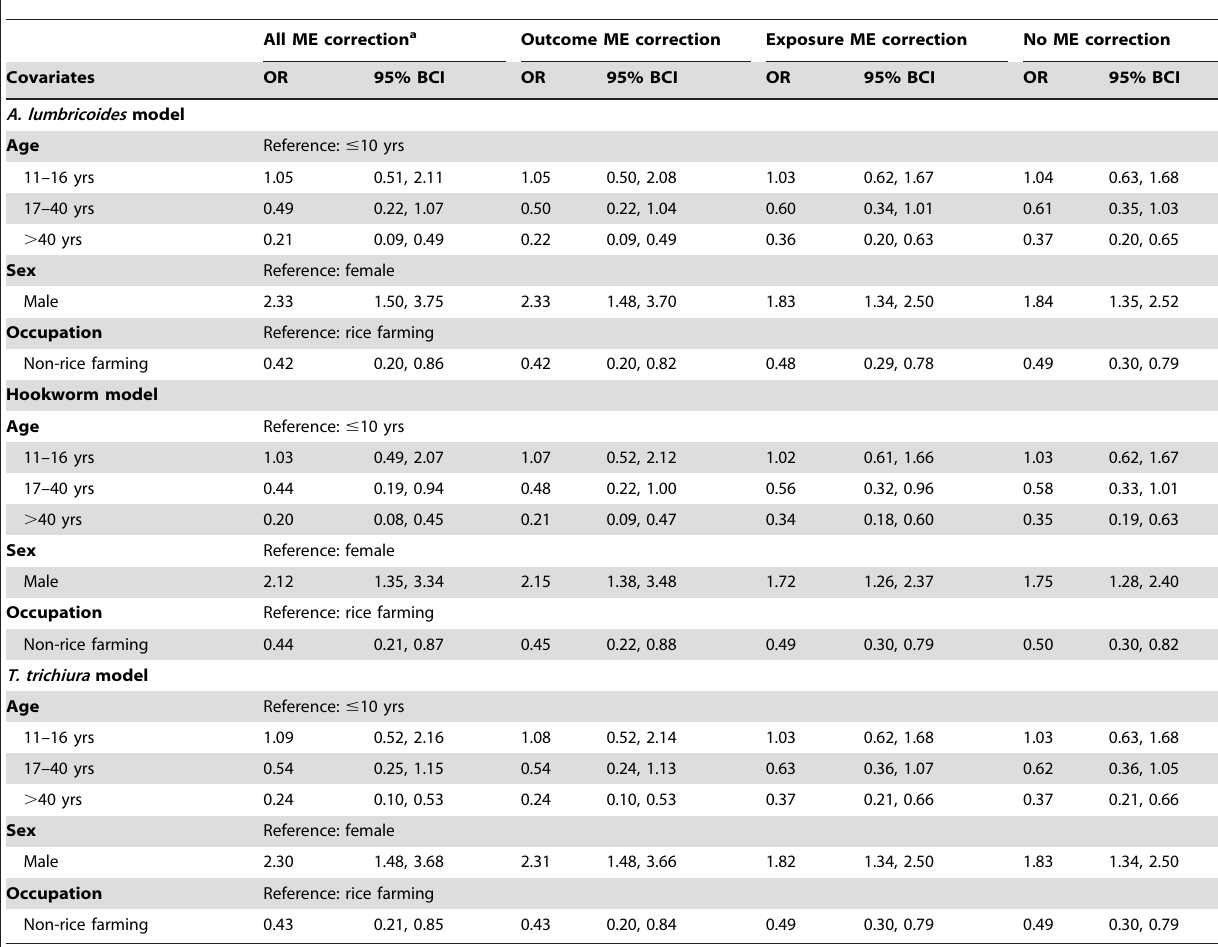
Table 2. Odds ratio estimates for covariates from A. lumbricoides , Hookworm, and T. trichiura models.